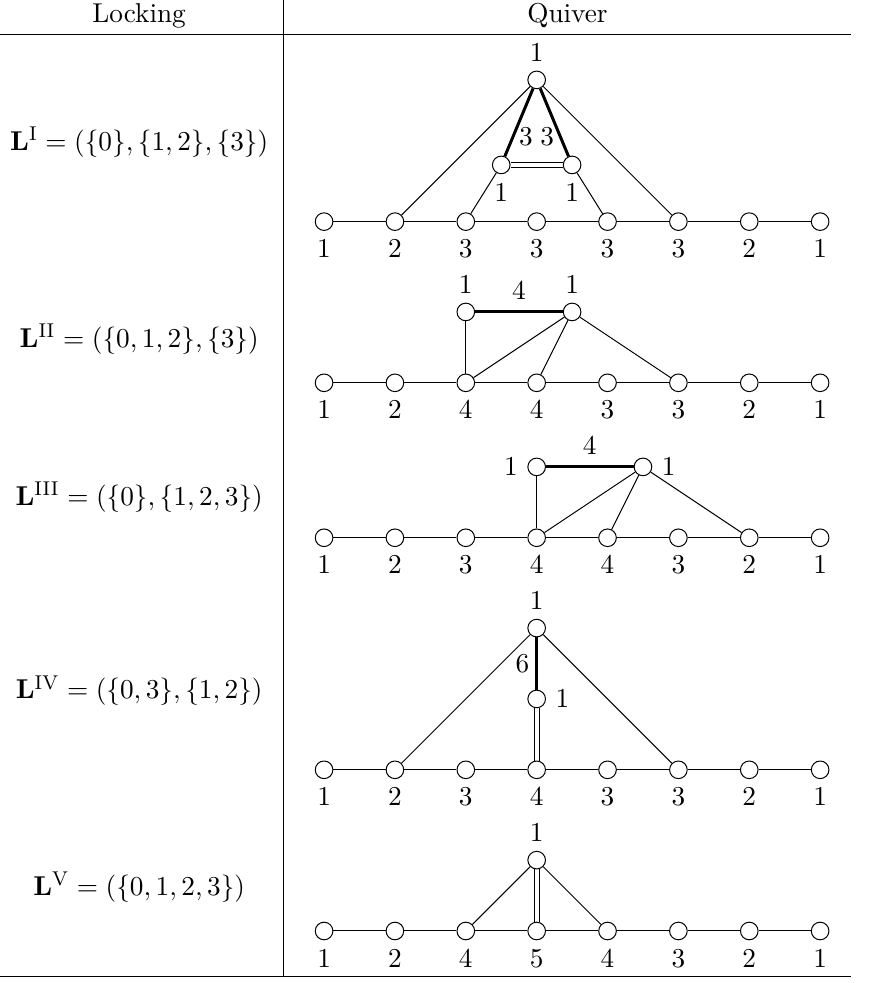
Table 6 . Quivers for the five cones of the Higgs branch of (3.2), corresponding to the five admissible lockings, which appear in blue in figure 2. When more than two lines connect two nodes, they are denoted by a thick line, with a number indicating the